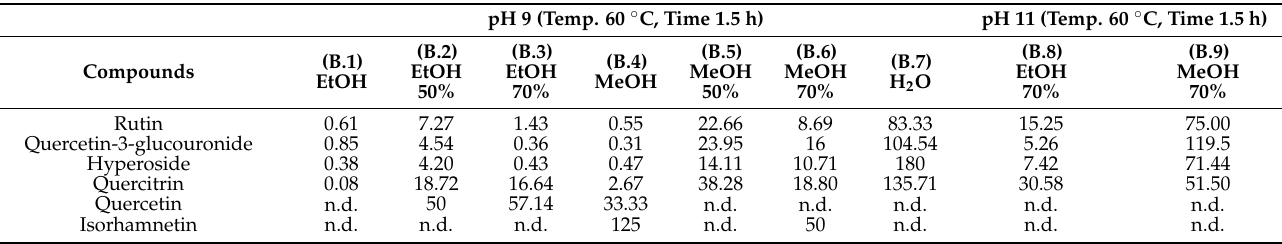
Table 5. Recovery percentages ( n = 2) for alkaline hydrolysis method.